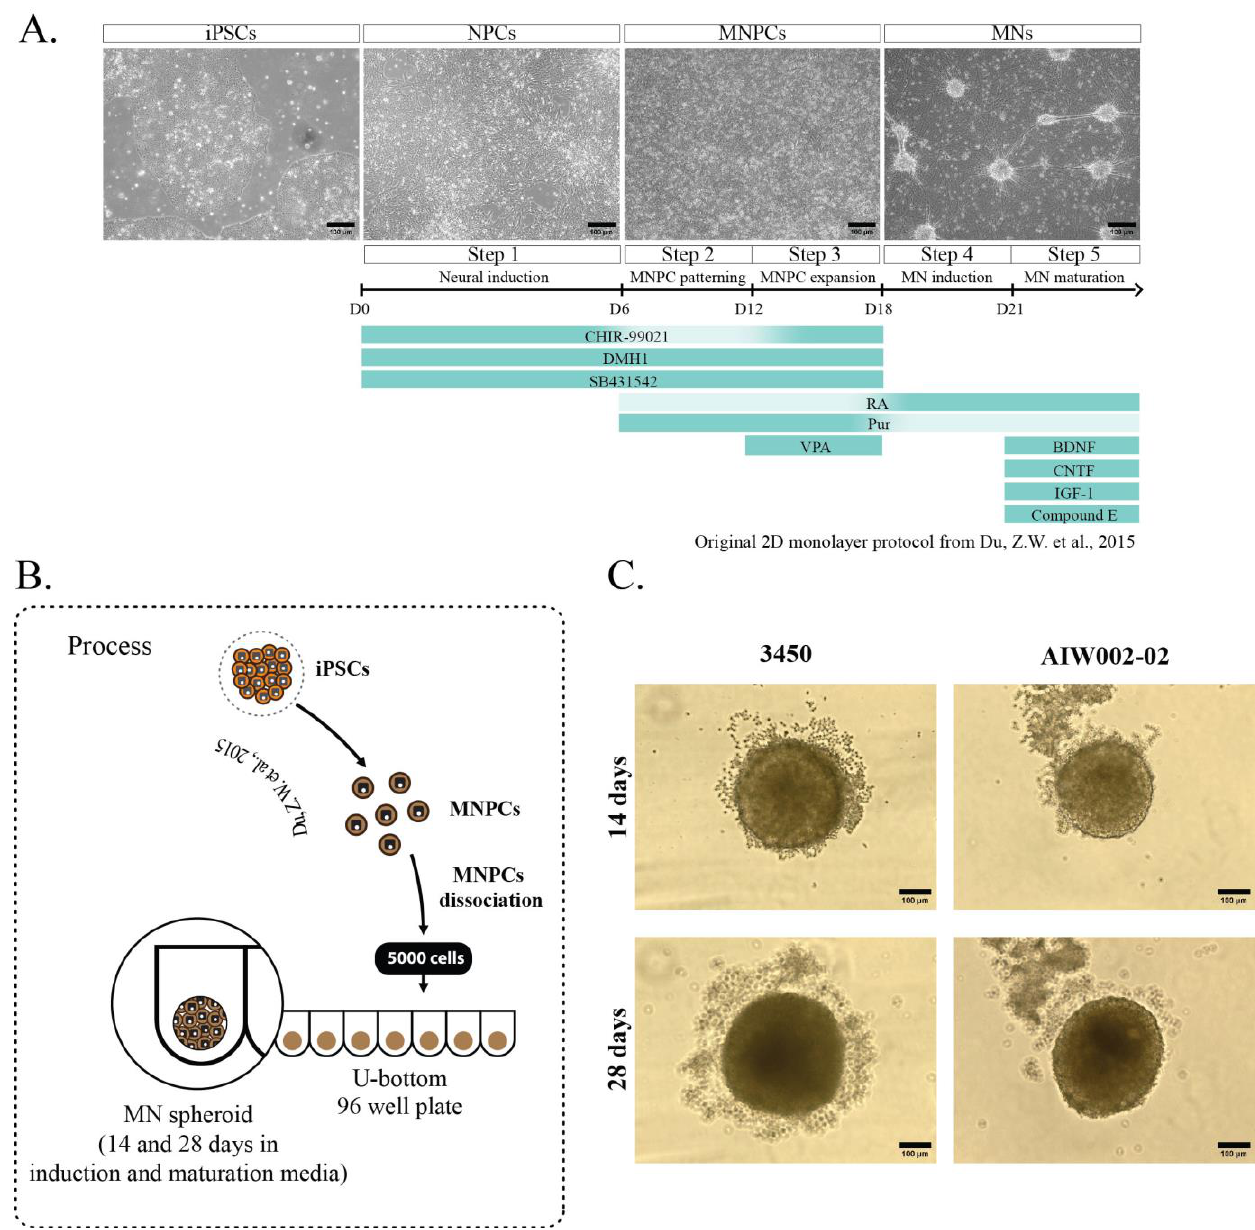
Figure 1. Generation of iPSC-derived MN spheroids. ( A ) Summary of the small-molecule protocol developed by [16] and optimized by our group to generate iPSC-derived MNs as a 2D monolayer. Briefly, iPSCs are differentiated towards neural progenitor cells (NPCs) that are patterned to motor neuron neural progenitor cells (MNPCs), which are finally differentiated into MNs. ( B ) At the MNPCs stage, two control cell lines (3450 and AIW002-02) were dissociated and plated into 96 U- bottom ultra-low attachment well plates in MN induction and maturation medium to generate MN spheroids that were kept in culture until their analysis. ( C ) Representative bright-field pictures of MN spheroids after 14 and 28 days of differentiation of both control cell lines.